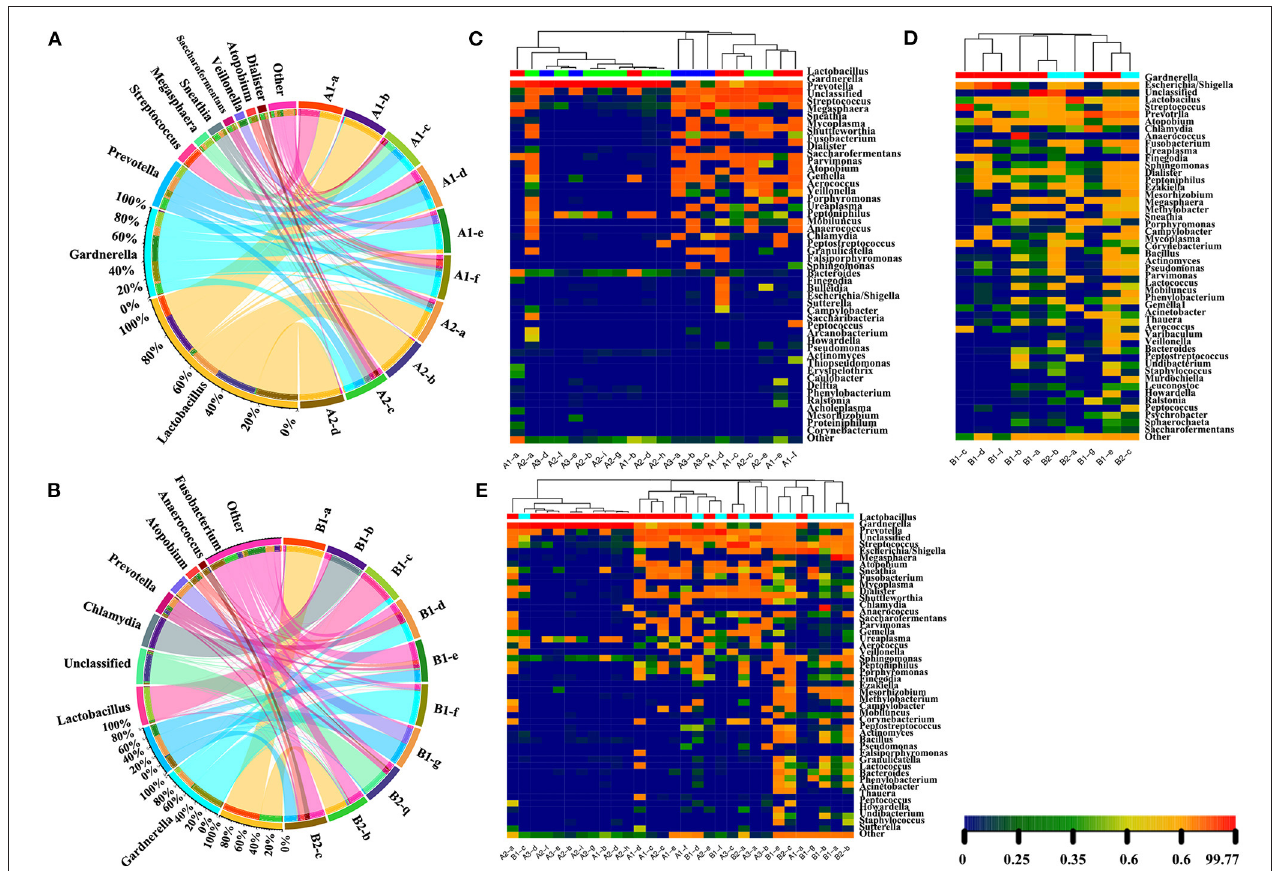
FIGURE 6 | The dominant flora and heatmap of genera from the tree diagram. The dominant flora in premenopausal (A) and postmenopausal (B) groups. The difference in abundance in samples on a branch is compared using a colored pie chart. Different colors represent different samples, and the larger the fan area of the color, the higher the abundance of the sample on the branch. The semicircle on the right indicates the species abundance composition of the sample, while the left semicircle indicates the proportion of different samples in the dominant species. The length and width represent the abundance and distribution ratio of species in the sample. Heat map of the top 50 species classifications at the genus-level species abundance matrix from a tree diagram. The distribution of flora in different phases of the menstrual cycle and postmenopausal women is shown in premenopausal women (C) , postmenopausal (D) and both (E) groups. The same sample group has the same color. Each column in the figure represents a sample, and the row represents the community structure. The color blocks represent relative species abundance values. The redder the color, the higher the relative abundance, while the bluer the color, the lower the relative abundance. The color shade reflects the abundance of the community distribution, and clustering reflects community similarities and different distributions at each classification